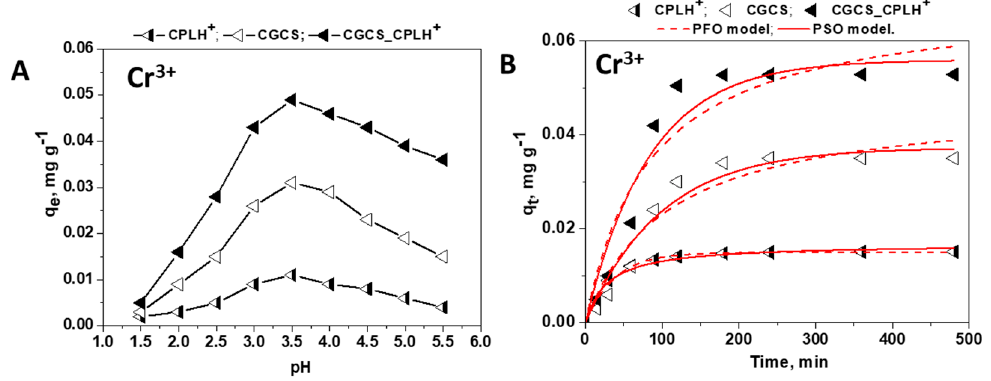
Figure 5. Influence of ( A ) pH values and ( B ) contact time onto Cr 3 + ions removal from multicomponent mixtures by CPLH + , CGCS, and CGCS_CPLH + sorbents.